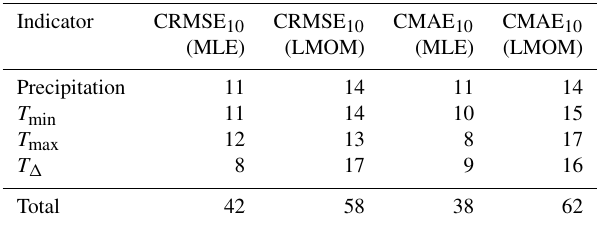
Table 5. Comparison of AMS and PDS approach based on condi- tional goodness-of-fit measures CRMSE 10 and CMAE 10 for two parameter estimation methods MLE and LMOM. Numbers indicate success cases of